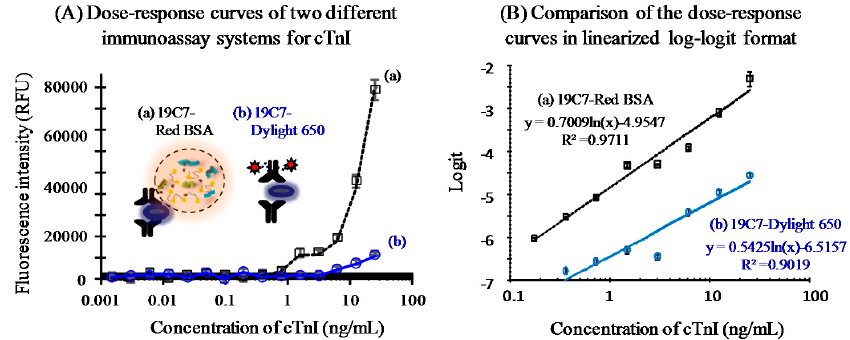
Figure 4. Analytical performance of two fluorometric immunoassay systems employing different signal generation techniques. The novel immunoassay based on protease treatment of Red-BSA was performed using the optimal digestion conditions (Figure 3). The dose-response curve showed a detection limit of 0.19 ng/mL cTnI ( A , a). A conventional immunoassay, in which the same detection antibody was labeled with Dylight650 fluorophore, was also employed ( A , b). The dose-response curve showed that the detection capability (0.78 ng/mL) was ~4.1-fold lower than that of the protease-assisted system. The two curves were linearized using log-logit transformation, which demonstrated the novel technique to have higher performance than the conventional approach ( B ).